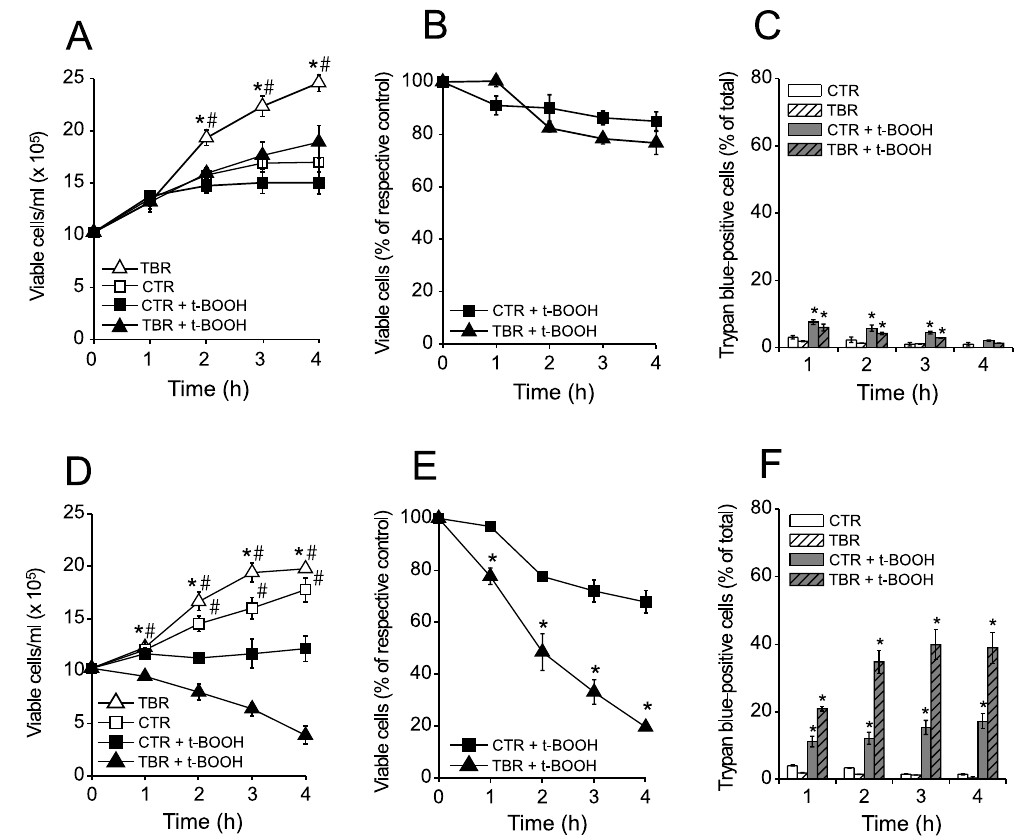
Fig. 6 – t-BOOH-induced lymphocyte cell death is prevented by cyclosporin A. (A; D) CTR and TBR lymphocytes were incubated for 4 h in the presence of 1 µ M cyclosporin A (A) or 0 . 5 µ M FK-506 (D) without other additions ( (cid:1) : CTR; (cid:3) : TBR) or with 500 µ M t-BOOH ( (cid:2) : CTR + t-BOOH; (cid:3) : TBR + t-BOOH). *p < 0 . 05 vs. CTR without t-BOOH; # p < 0 . 05 vs. respective group with t-BOOH. (B; E) Effect of t-BOOH on the percentage of viable cells considering their respective controls at each time point when the incubations were conducted in the presence of 1 µ M cyclosporin A (B) or 0.5 µ M FK-506 (E) ( (cid:2) : CTR + t-BOOH; (cid:3) : TBR + t-BOOH). *p < 0 . 05 vs. CTR + t-BOOH. (C; F) Death of CTR and TBR lymphocytes incubated with 1 µ M cyclosporin A (C) or 0 . 5 µ M FK-506 (F), in the absence of 500 µ M t-BOOH (CTR: open bars; TBR: open hatched bars) or in its presence (CTR: gray bars; TBR: gray hatched bars). Viability was estimated by the trypan blue exclusion method repeated hourly for 4 h. *p < 0 . 05 vs. respective group without